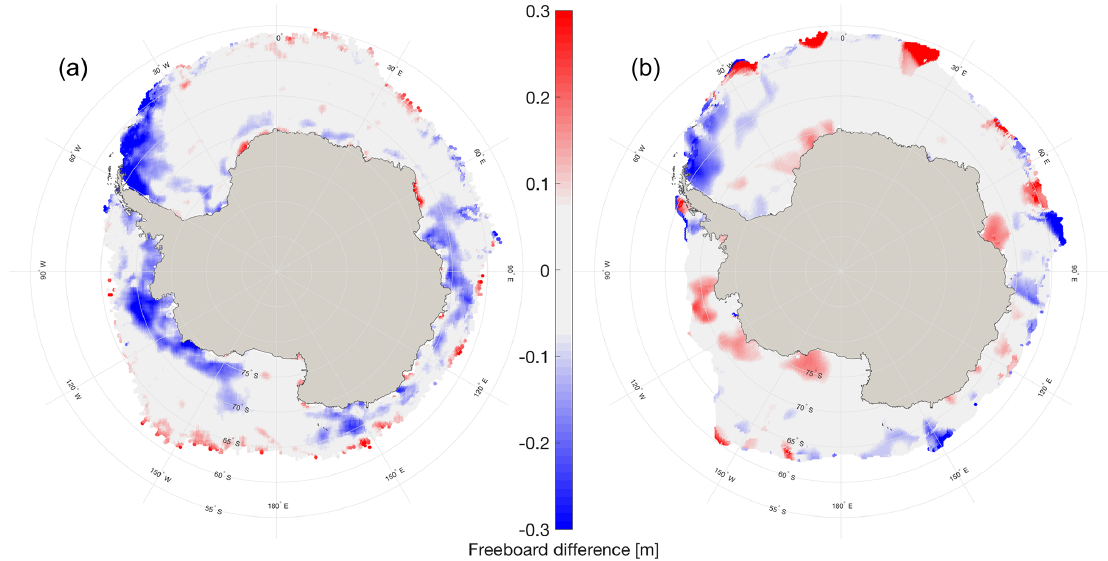
Figure 10. Snow freeboard differences showing (a) CryoSat-2 October 2011–2017 average minus ICESat spring 2003–2007 average and (b) ICESat spring 2006 average minus ICESat spring 2003–2007 average. The year 2006 is included as an example year to highlight the interannual variability in the freeboard